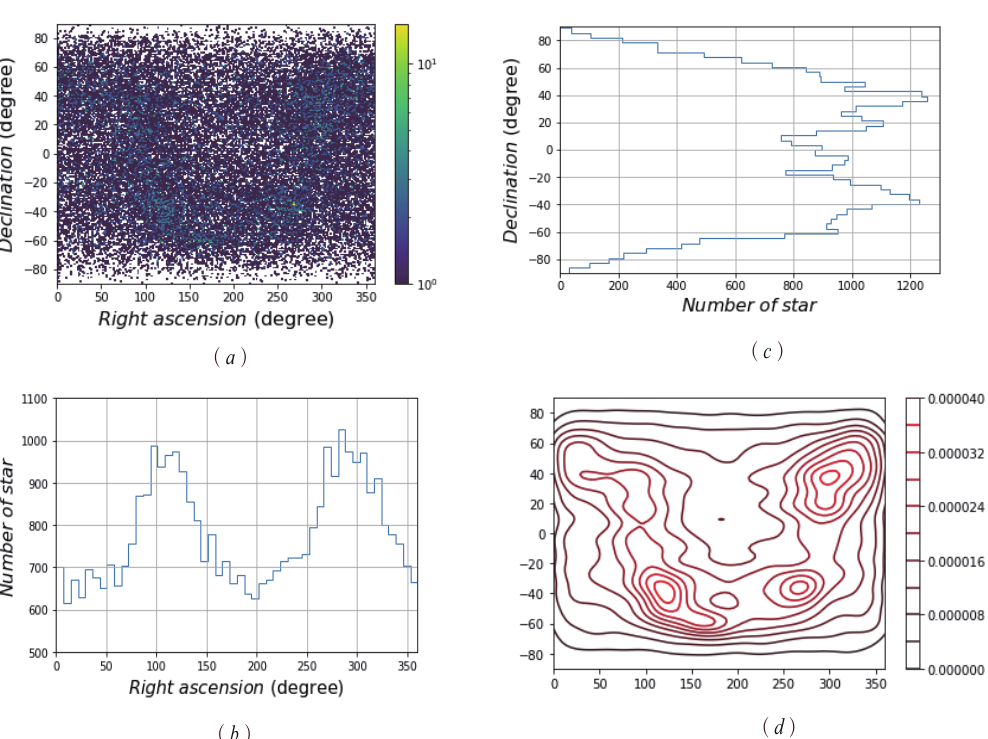
Figure 5. The scattered data density of the MFM star catalogue. ( a ) The distribution density of MFM GSC; ( b ) the statistics of the NOS distributed in the direction of right ascension; ( c ) the statistics of the NOS distributed in the direction of declination; ( d ) the nuclear density line of MFM GSC stars in the celestial